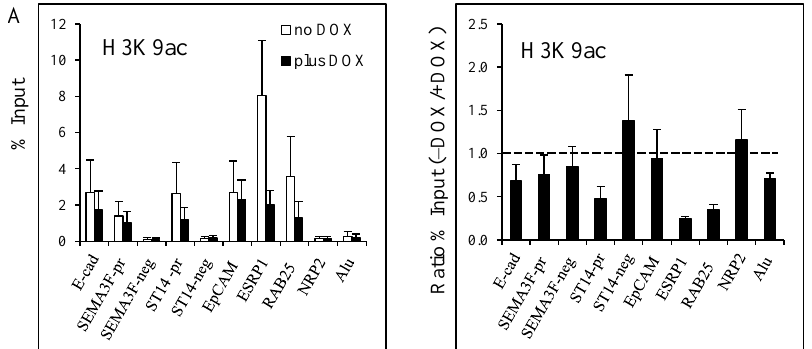
Figure 5. Decrease of histone H3K9 and H3K27 acetylation induced by ZEB1 binding on target genes. ChIP assays were performed with the rabbit anti-acetyl H3K9 ( A ), and anti-acetyl H3K27 ( B ) antibodies on H358 FlipIn ZEB1 cells grown for 48 h in the absence (white bars) or in the presence (black bars) of DOX. Results are expressed as % of input (left column). The ratio of the % input obtained without and with DOX for each experiment is shown in the right column with a value 1.0 indicating no change. Values are from three independent experiments with PCR in duplicate. Bars,